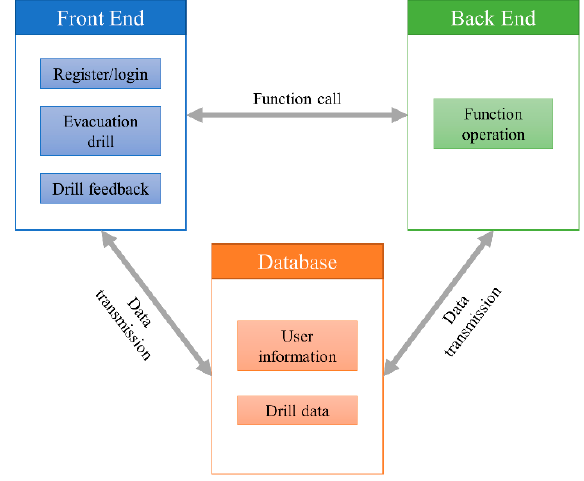
Figure 2. System structure of the web-based serious game.